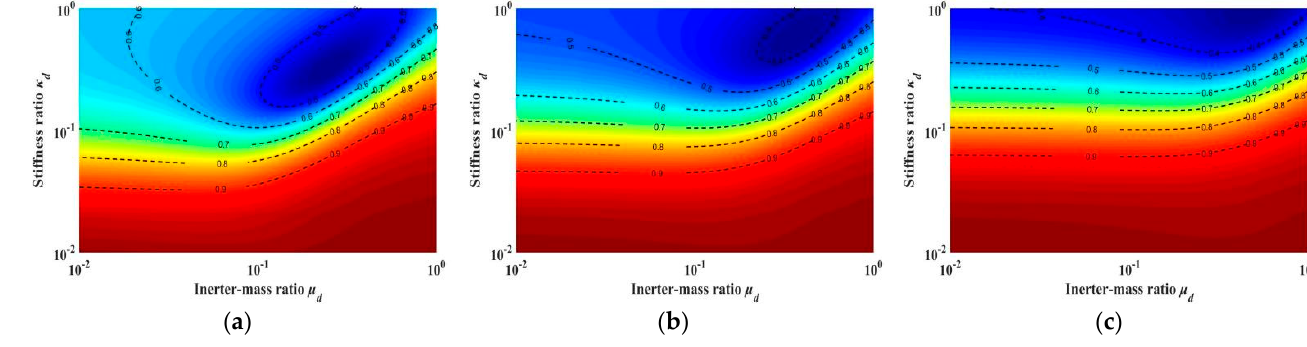
Figure 11. 2D Contour plot of γ Ur of HC system: ( a ) ζ d = 0.05; ( b ) ζ d = 0.10; and ( c ) ζ d = 0.15.